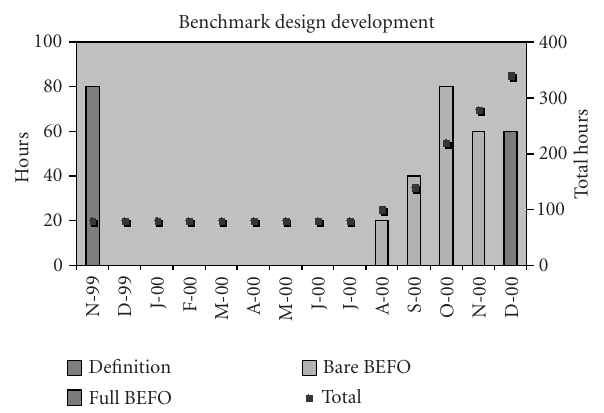
Figure 11: Radar design and development duration.